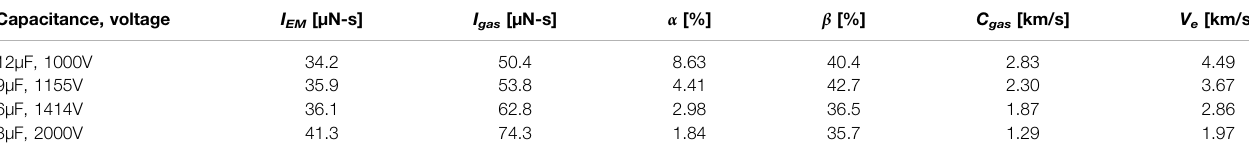
TABLE 9 | APPT performance parameters under different capacitance and voltage con fi gurations. Capacitance, voltage